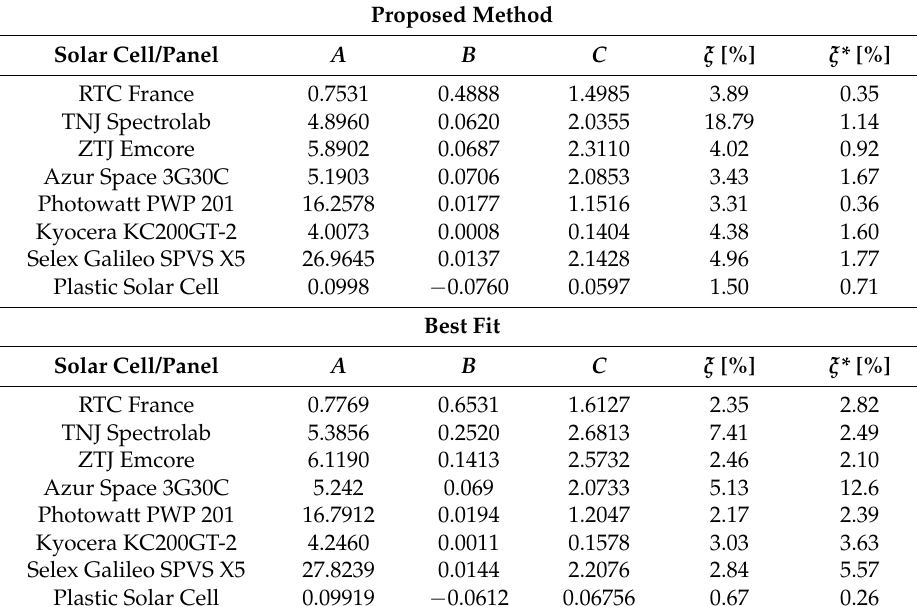
fittings, ξ , and ξ * , are included in the